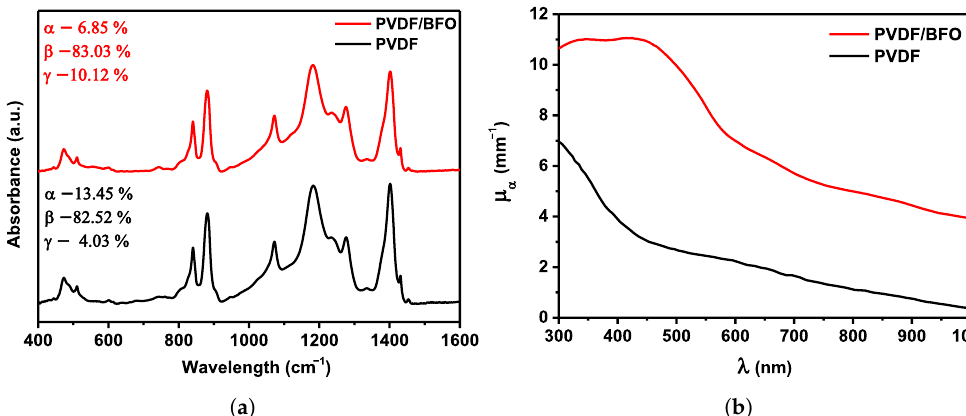
Figure 2. ( a ) FTIR absorption spectra of fibers made of PVDF/BFO and pure PVDF. ( b ) Absorption coefficient spectra— µ a of PVDF/BFO and pure